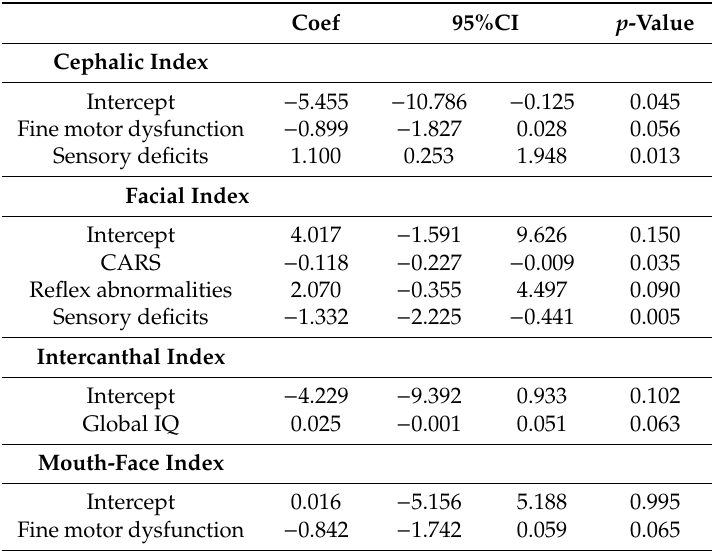
Table 4. Standard multiple regression analyses on anthropometric z-scores as dependent variables and demographic characteristics, global QI, CARS and MND. Coef 95%CI p -Value Cephalic Index Intercept −